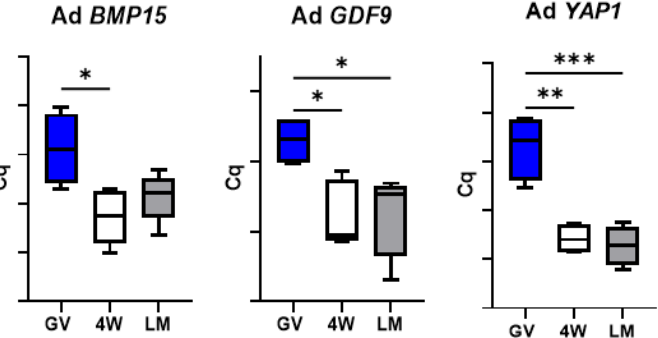
Figure 7. Expression of oocyte-secreted factors in pools of adult GV and MII oocytes matured in 4-well plates (4W) or in liquid marbles (LM). Target gene expression was normalized against the luciferase exogenous control. Relative abundance is expressed as ∆ Cq ( Y -axis). Each box represents the mean expression of 5 replicate pools of 10 oocytes each (mean ± SE). Significant differences were assessed by ANOVA general linear model test; * p < 0.05, ** p < 0.01, *** p < 0.001.